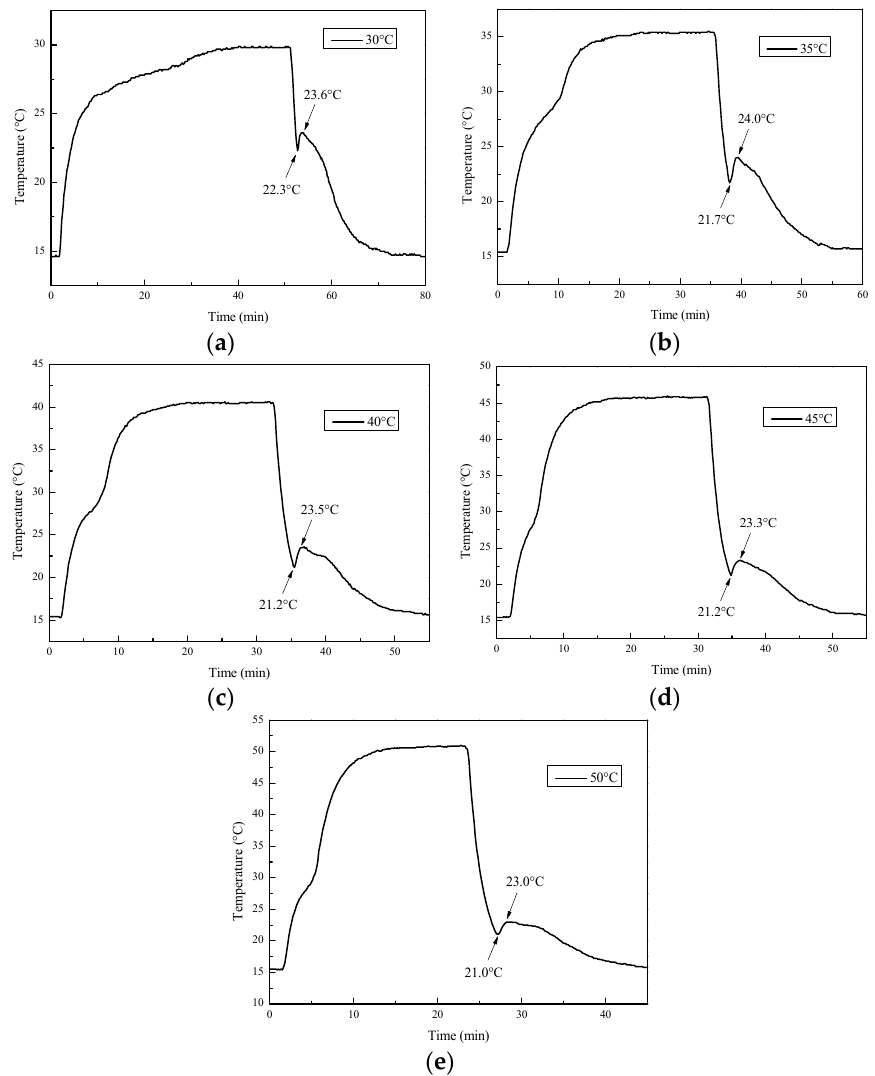
Figure 13. Cooling curves of the Na 2 SO 4 ·10H 2 O eutectic composite phase change materials (CPCMs) at different ambient temperatures: ( a – e ) 30–50 °C.